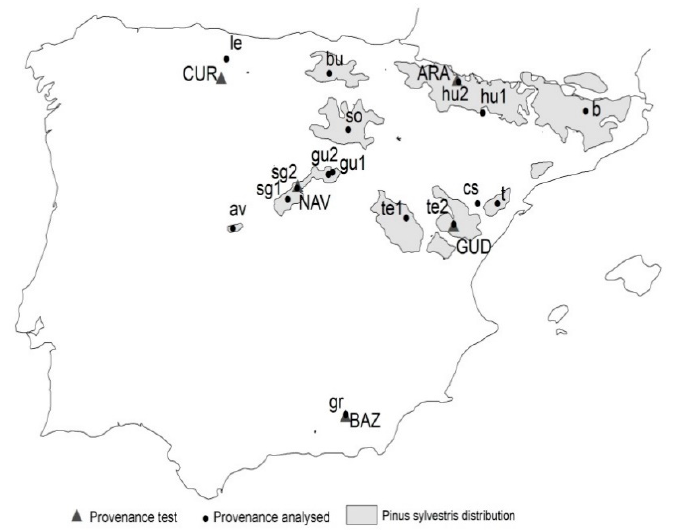
Figure 1. Location of population and sites used in this study.